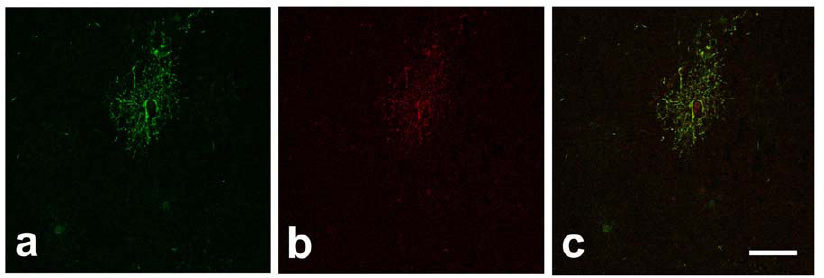
Figure 4. Gng2 are expressed in glial cells as analyzed by double-labeling immunohistochemistry and confocal microscopy. Gng2 identified by anti-rabbit antiserum conjugated with FITC (a), GFAP identified by anti-mouse antiserum conjugated with TRITC (b); merge image (c) shows co-localization of the two substances. Scale bar =10 m m.